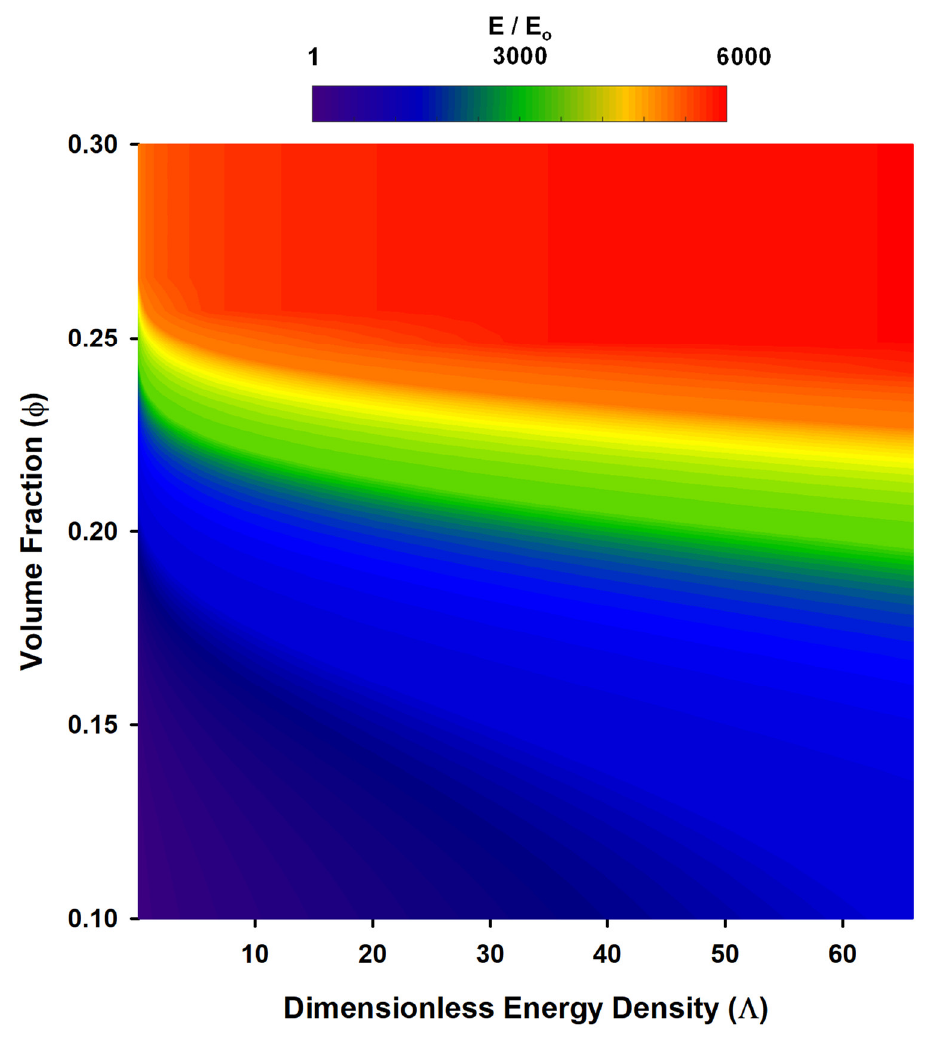
Figure 8. A contour plot of normalized Young’s modulus (Equation (16)) illustrating the impact that filler particle volume fraction and the dimensionless energy density of an applied external field have on mechanical properties. The field influences the RDF of the filler particles (Equation (18)), which also influences Young’s modulus as described by Equation (16).